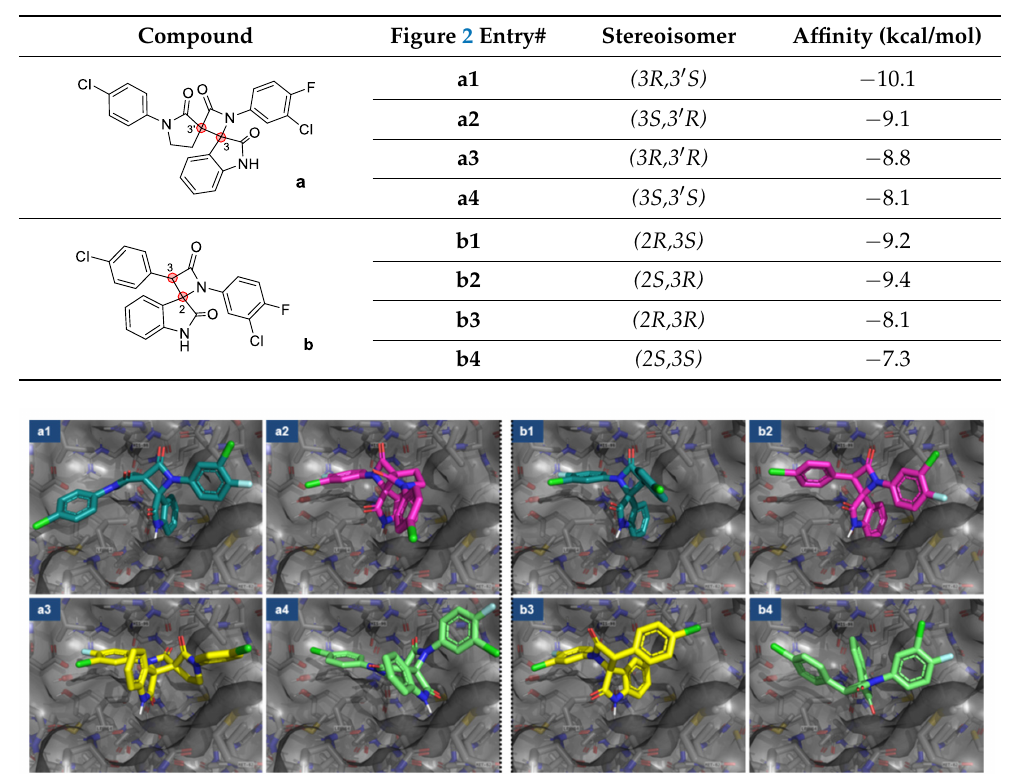
Figure 2. Molecular docking studies of dispiro- ( a ) and spiro- ( b ) indolin-2-ones (see Table 1). Binding modes of four stereoisomers of dispirooxindole- β -lactam ( a1 – a4 ) are compared to isomers of previously studied spirooxindole- β -lactam ( b1 – b4 ) with same-side aryl substituents: ( a1 ) ( 3R,3 (cid:48) S ), ( a2 ) ( 3S,3 (cid:48) R ), ( a3 ) ( 3R,3 (cid:48) R ), ( a4 ) ( 3S,3 (cid:48) S ); ( b1 ) ( 2R,3S ), ( b2 ) ( 2S,3R ), ( b3 ) ( 2R,3R ), ( b4 ) ( 2S,3S